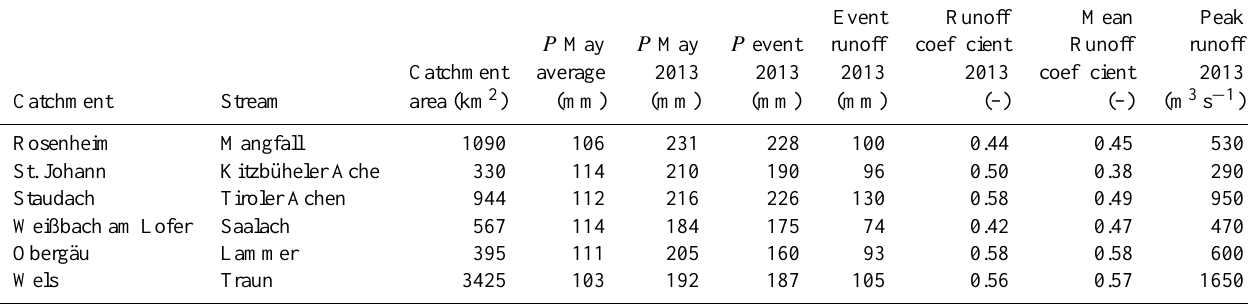
Table 1. Characteristics of the June 2013 flood in small catchments in the Upper Danube Basin with particularly high event precipitation. Catchment precipitation in May ( P May, average 1976–2011), May 2013 ( P May 2013, 1–29 May 2013), during the event ( P event 2013, 30 May–4 June, 2013), event runoff of 2013 flood, runoff coefficient of 2013 flood, mean runoff coefficients for events with precipitation >50mm, and 2013 peak runoff. For catchment locations see Fig. 1. Runoff coefficients are from Merz and Blöschl (2009) and Merz et al.